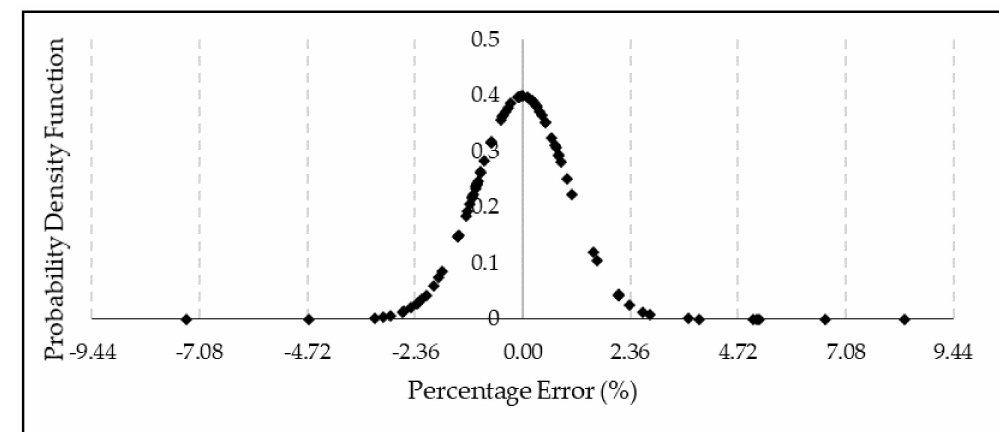
Figure 15. Probability distribution of the percentage error obtained using the newly developed failure pressure prediction method and FEM based on the parameters of the ANN training